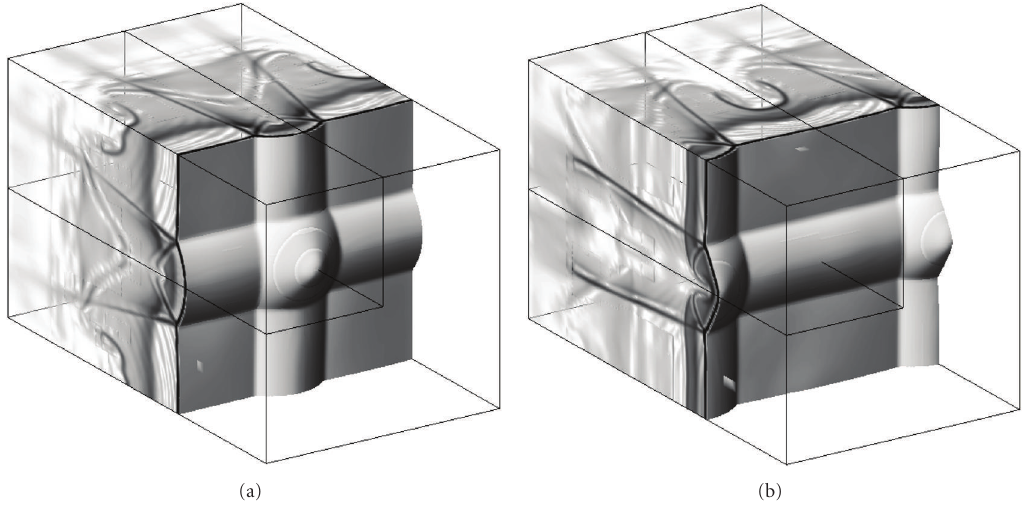
Figure 14: Schlieren plots of density, mirrored at x 2 = 0 cm for visualization, 5.0cm < x 1 < 7.0cm.